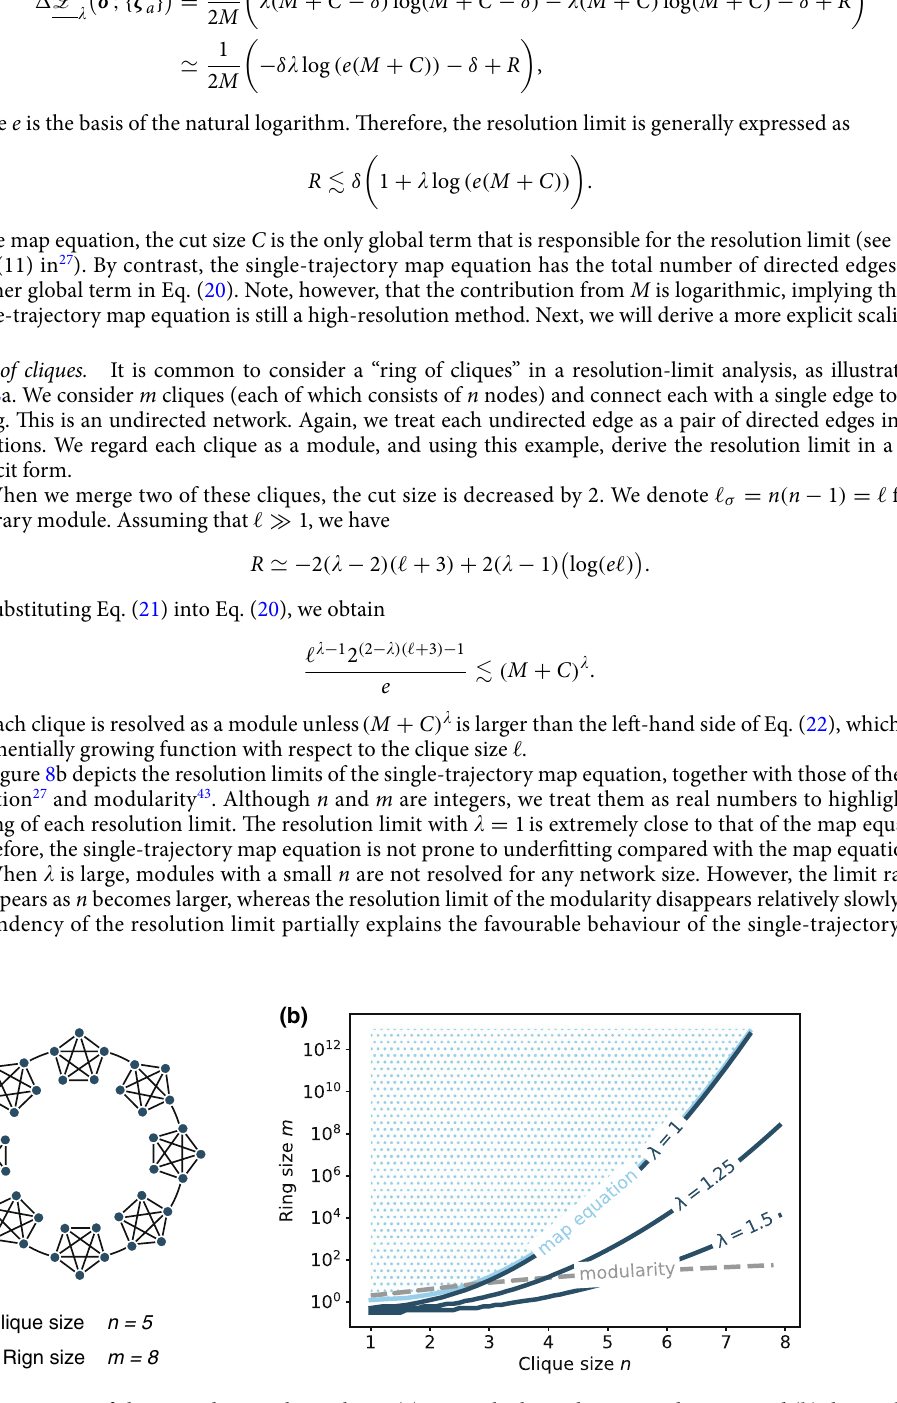
Figure 8. Ring of cliques and its resolution limit. ( a ) Network plot with n = 5 and m = 8 , and ( b ) the resolution limits of the map equation (light blue line), the single-trajectory map equation with (cid:31) = ( 1, 1.25, 1.5 ) (dark blue lines), and the modularity (dashed grey line). Each line represents the phase boundary above which a clique is not resolved as a module because the network is too large (e.g., the marked region represents the undetectable region in the map